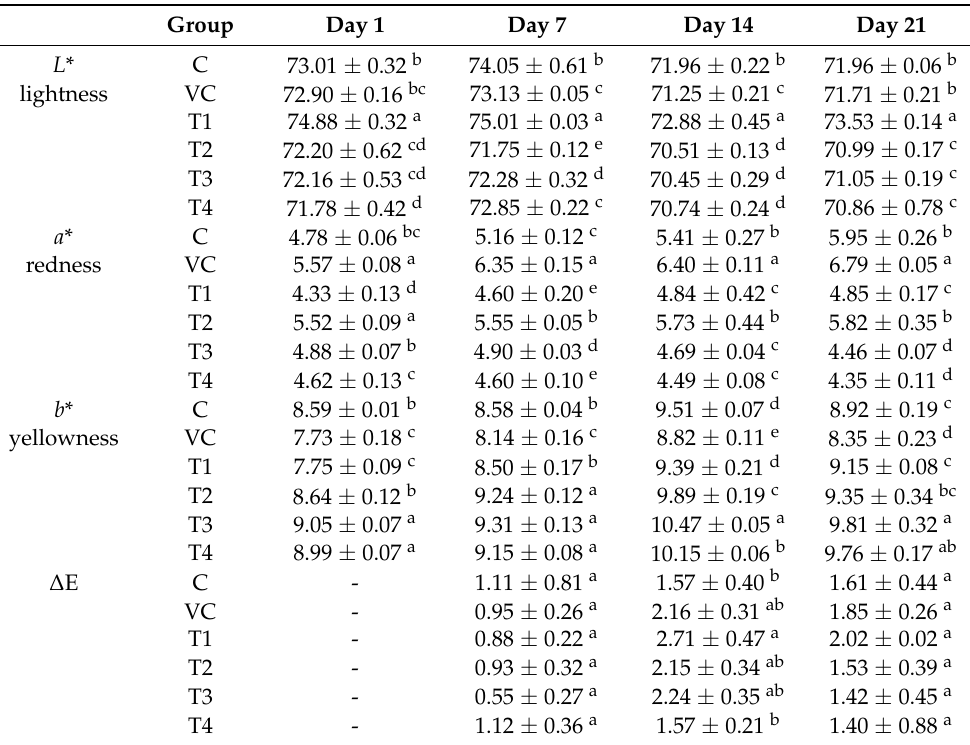
Table 3. Changes of color parameters and total color difference ∆ E of frankfurters during storage at 4 ◦ C (n =